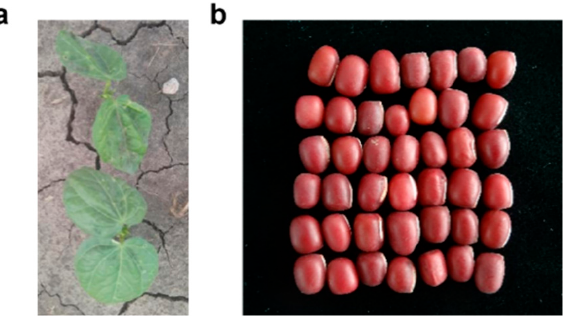
Figure 1. Adzuki bean. ( a ) Seedlings of adzuki beans ( Vigna angularis ) in the field [7]. ( b ) Seeds of adzuki beans ( Vigna angularis ).